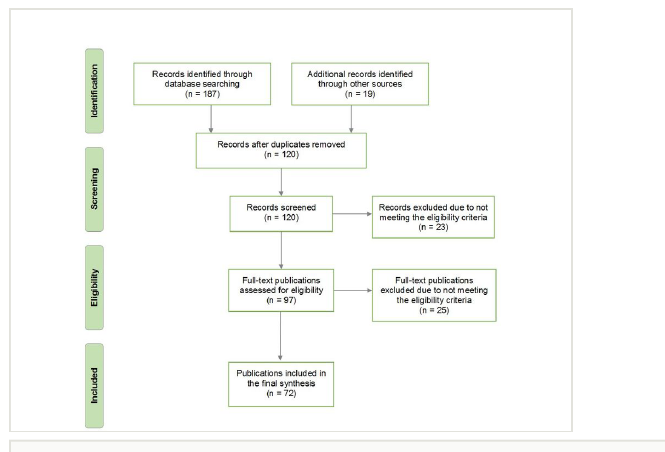
Figure 1. Literature review fl ow diagram . The literature review followed the Preferred Reporting Items for Systematic reviews and Meta-Analyses (PRISMA) (Moher 2009).